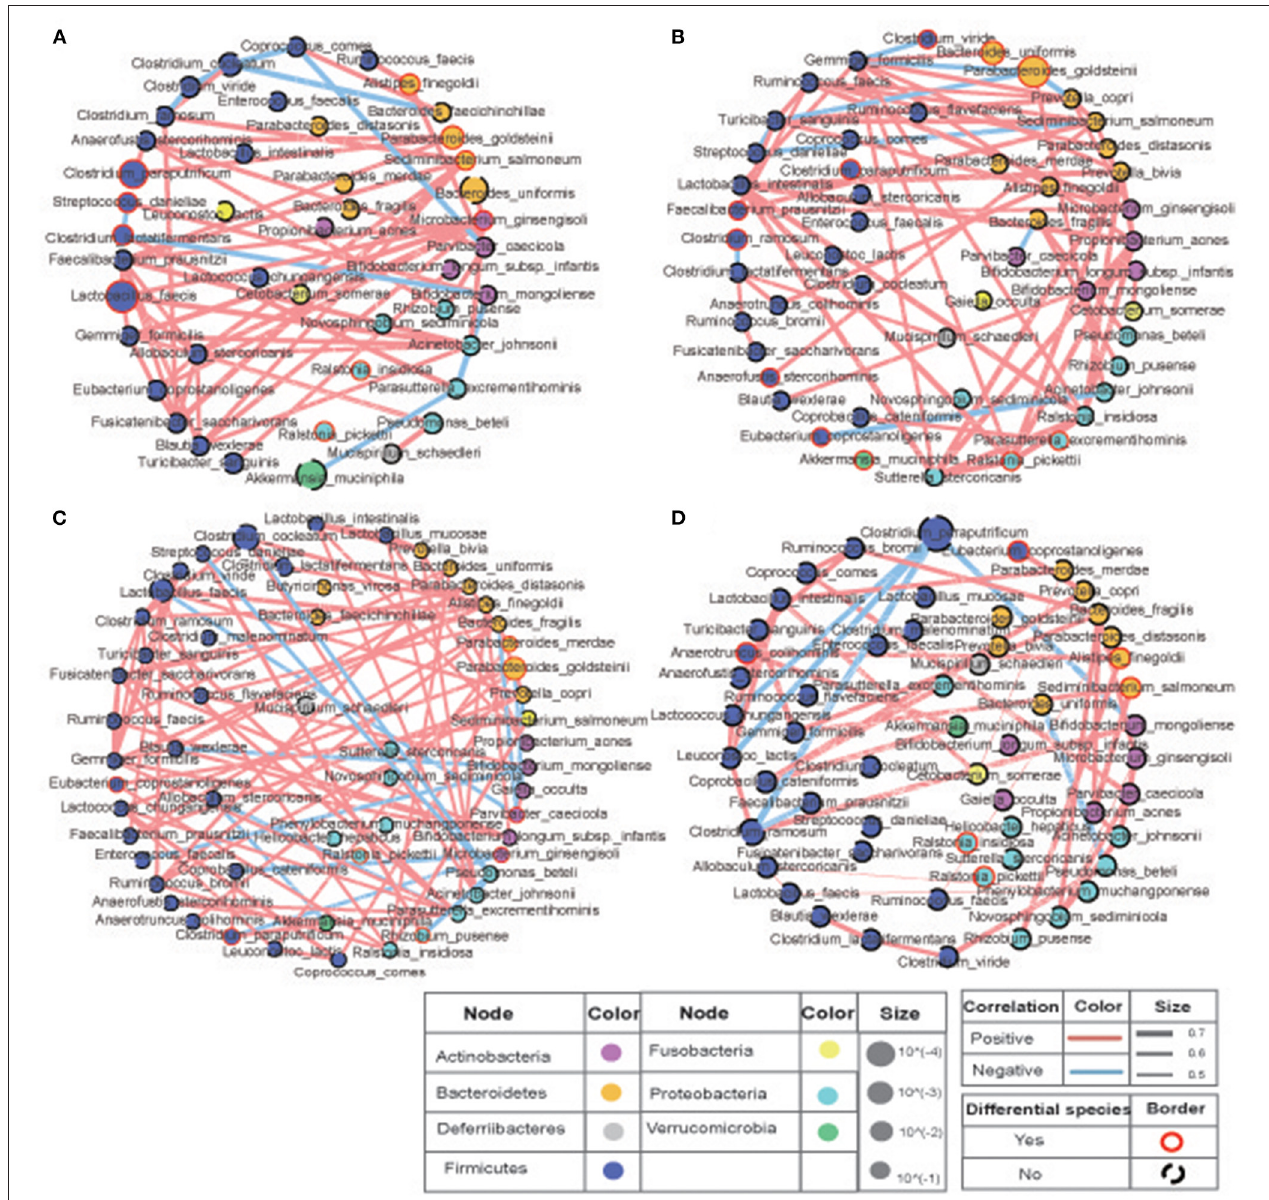
FIGURE 4 | Correlations of the bacteria in murine intestine. The size of the circle represents the relative abundance, the color of the circle represents the phylum to which it belongs, the red line is positive correlation, the blue line is negative correlation. Compared with the low-fat diet (A) L and (B) LC groups, the high-fat diet (C) H and (D) HC groups had more complex interactions between the bacteria and tremendous change occurred in their relationship. COS stimulation enabled Clostridium ramosume to establish positive interactions with Faecalibacterim prausnitzii and Clostridium paraputrificum ; Clostridium paraputrificum also established positive interactions with Lactococcus chungangensis and Bifidobacterium mongoliense (B,D) . Groups: Group L (low-fat diet group, fed with 4.3% fat, 5% cellulose); LC group (low-fat diet + COS group, fed with 4.3% fat, 5% COS); group H (high-fat diet group, fed with 35.4% fat, 5% cellulose); and HC group (high Fat diet + COS group, fed with 35.4% fat, 5%